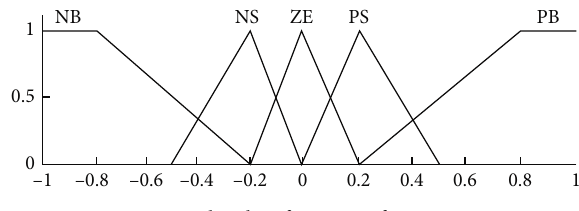
Figure 6: Membership function of yaw rate error.